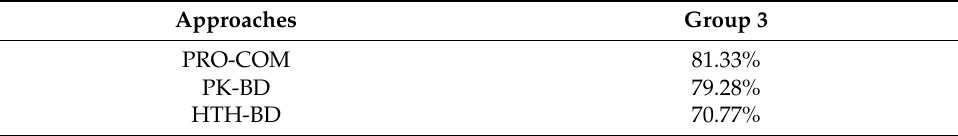
Table 21. The accuracy considering the group